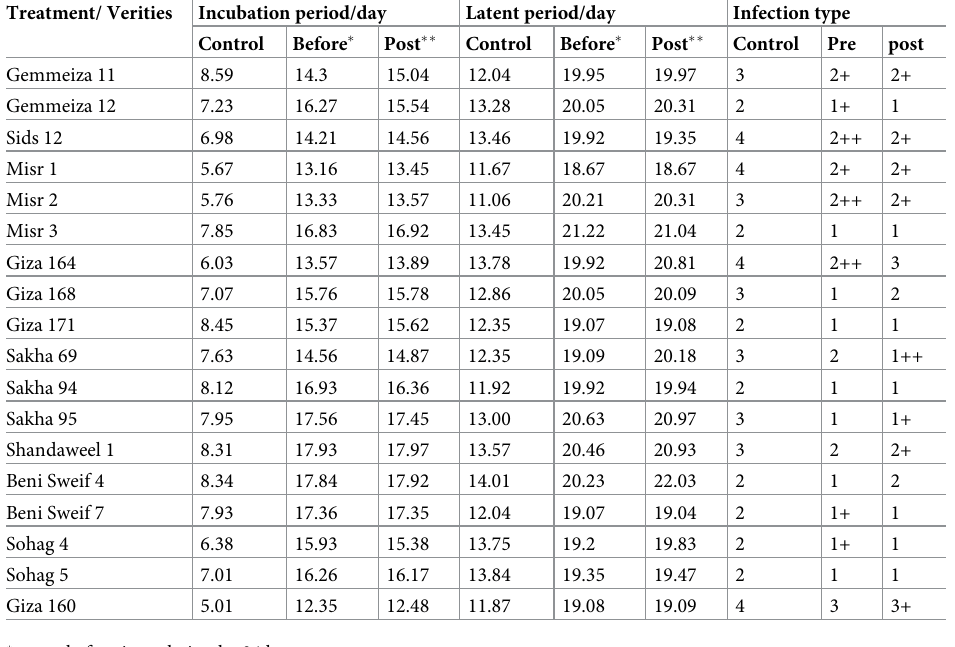
Table 9. Effect of Cu-chitosan NPs treatments and application methods on incubation, latent periods and infec- tion type of the wheat stem rust disease. Treatment/